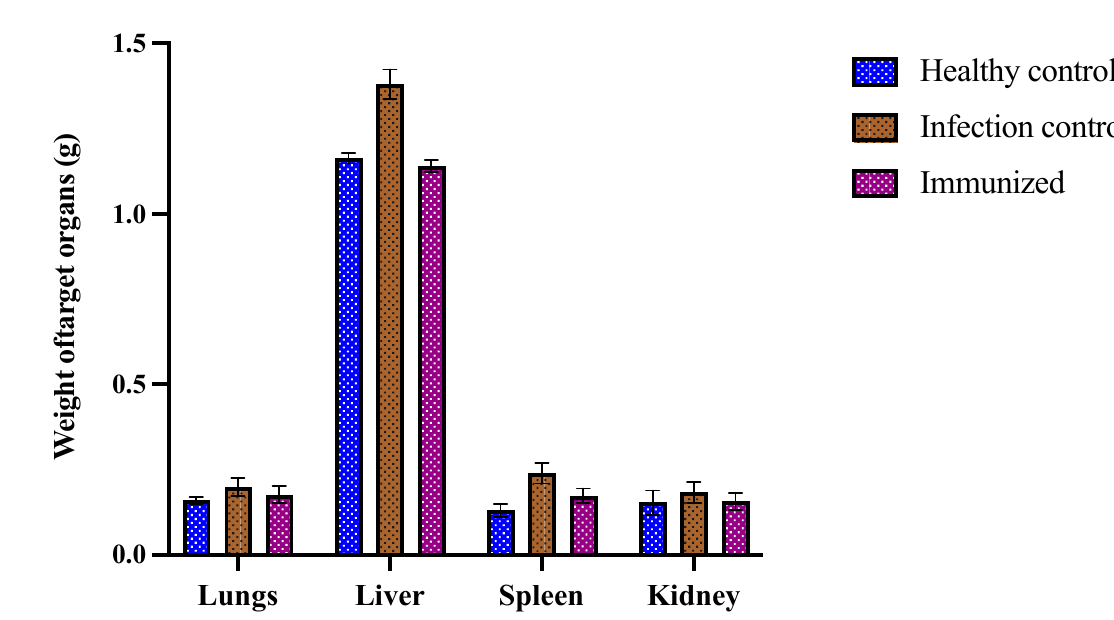
Figure 8. Average weight of target organs (g). Post-sacrifice, the target organs were removed and weighed to study the difference in weight between organs (lungs, liver, spleen, and kidney) among healthy, infected, and immunized groups.